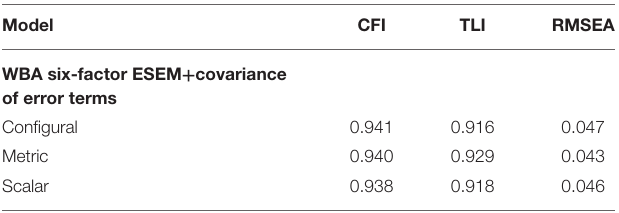
TABLE 3 | Goodness of fit for time measurement invariance models based on the T1 and T2 stacked file.